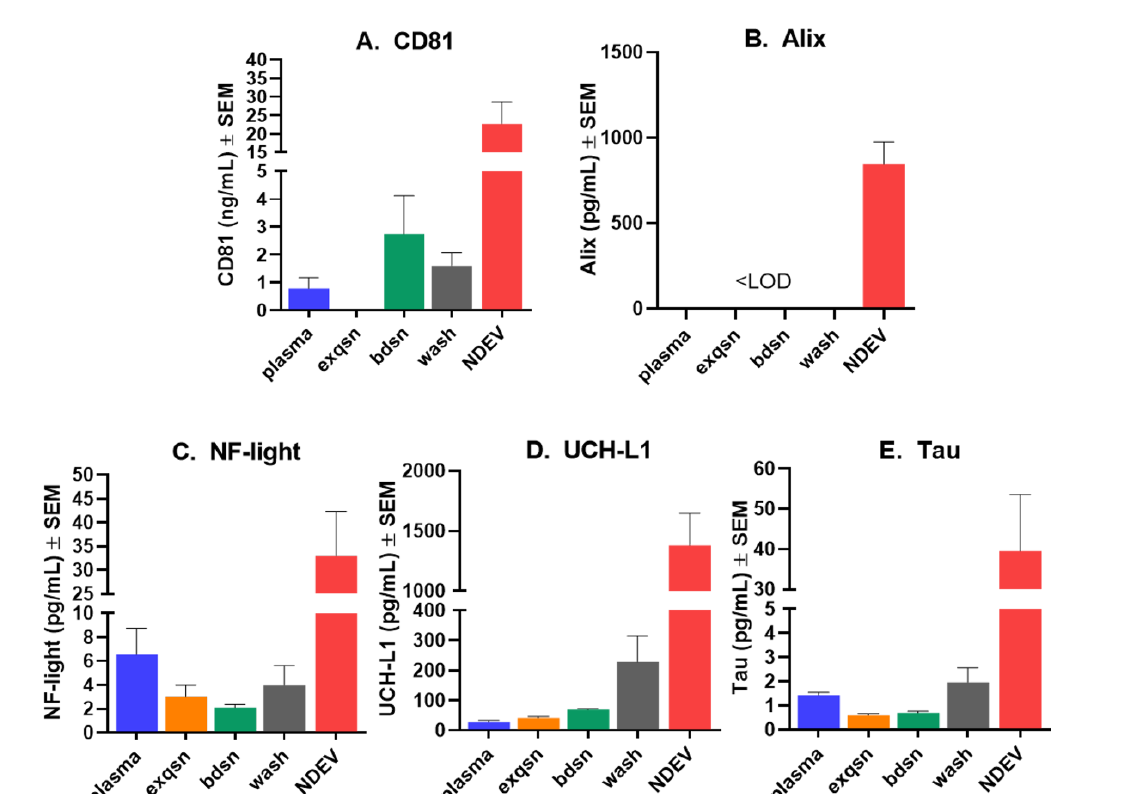
Figure 3. Quantification of biomarkers showing enrichment for neuron-derived EVs. Biomarkers were measured in plasma, EV-depleted plasma (exqsn), bead supernatant (bdsn), wash supernatant (wash) and in NDEVs (described in Figure 1). Levels of small EV-associated tetraspanin CD81 ( A ) and Alix ( B ) were measured using commercial ELISA kits (Cusabio). Levels of neuron-specific proteins NF-light ( C ), UCH-L1 ( D ) and Tau ( E ) in plasma were measured using Simoa assay kits on the SR-X instrument (Quanterix). Note that NDEVs contained significantly higher levels of all components including the neuron-specific markers, strongly suggesting that the immunoprecipitation procedure for NDEVs had succeeded. The same process was used to obtain the NDEVs for injection into mouse brain. Table 1. Levels of biomarkers measured in NDEV enriched from plasma samples from one participant with DS-AD and one